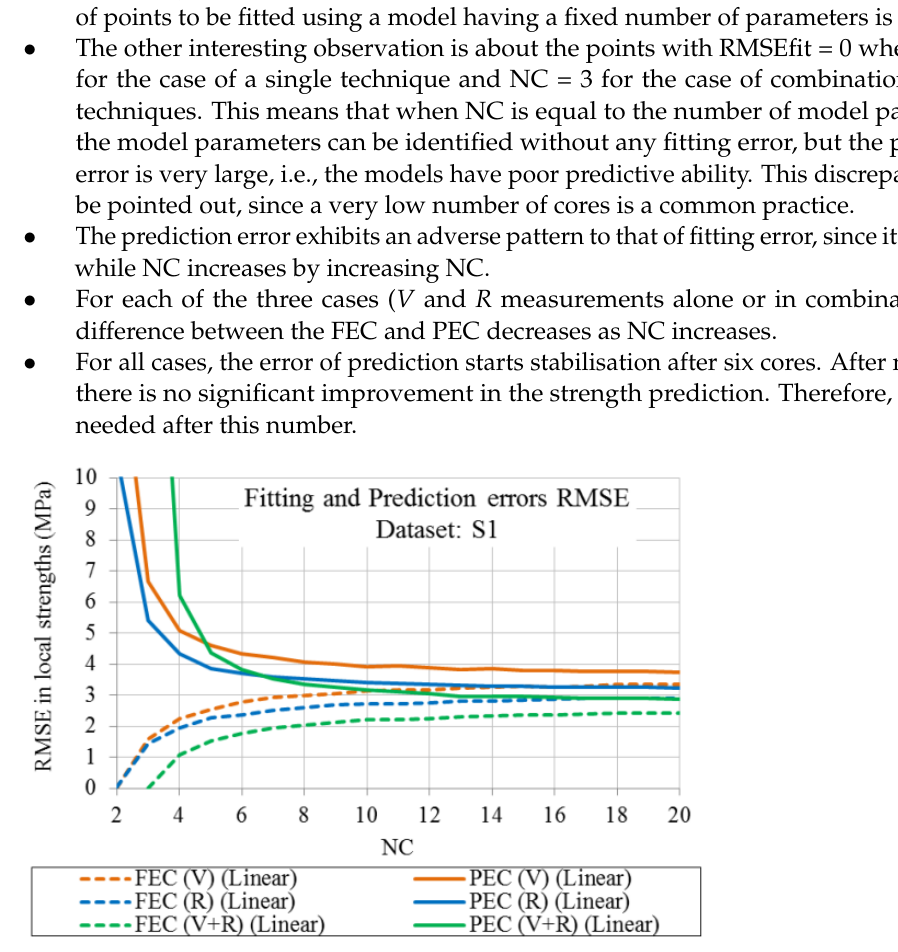
Figure 4. Fitting and prediction errors (FEC and PEC) as a function of NC resulting from analyzing the in situ dataset S1 [40].